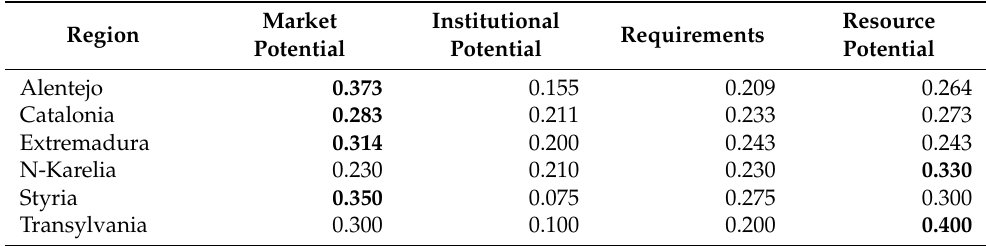
Table 4. Regional weights for the criteria of the decision problem per case study region, with the most relevant criterion highlighted in bold letters. Resource Market Institutional Requirements Region Potential Potential Potential Alentejo 0.373 0.155 0.209 0.264 0.283